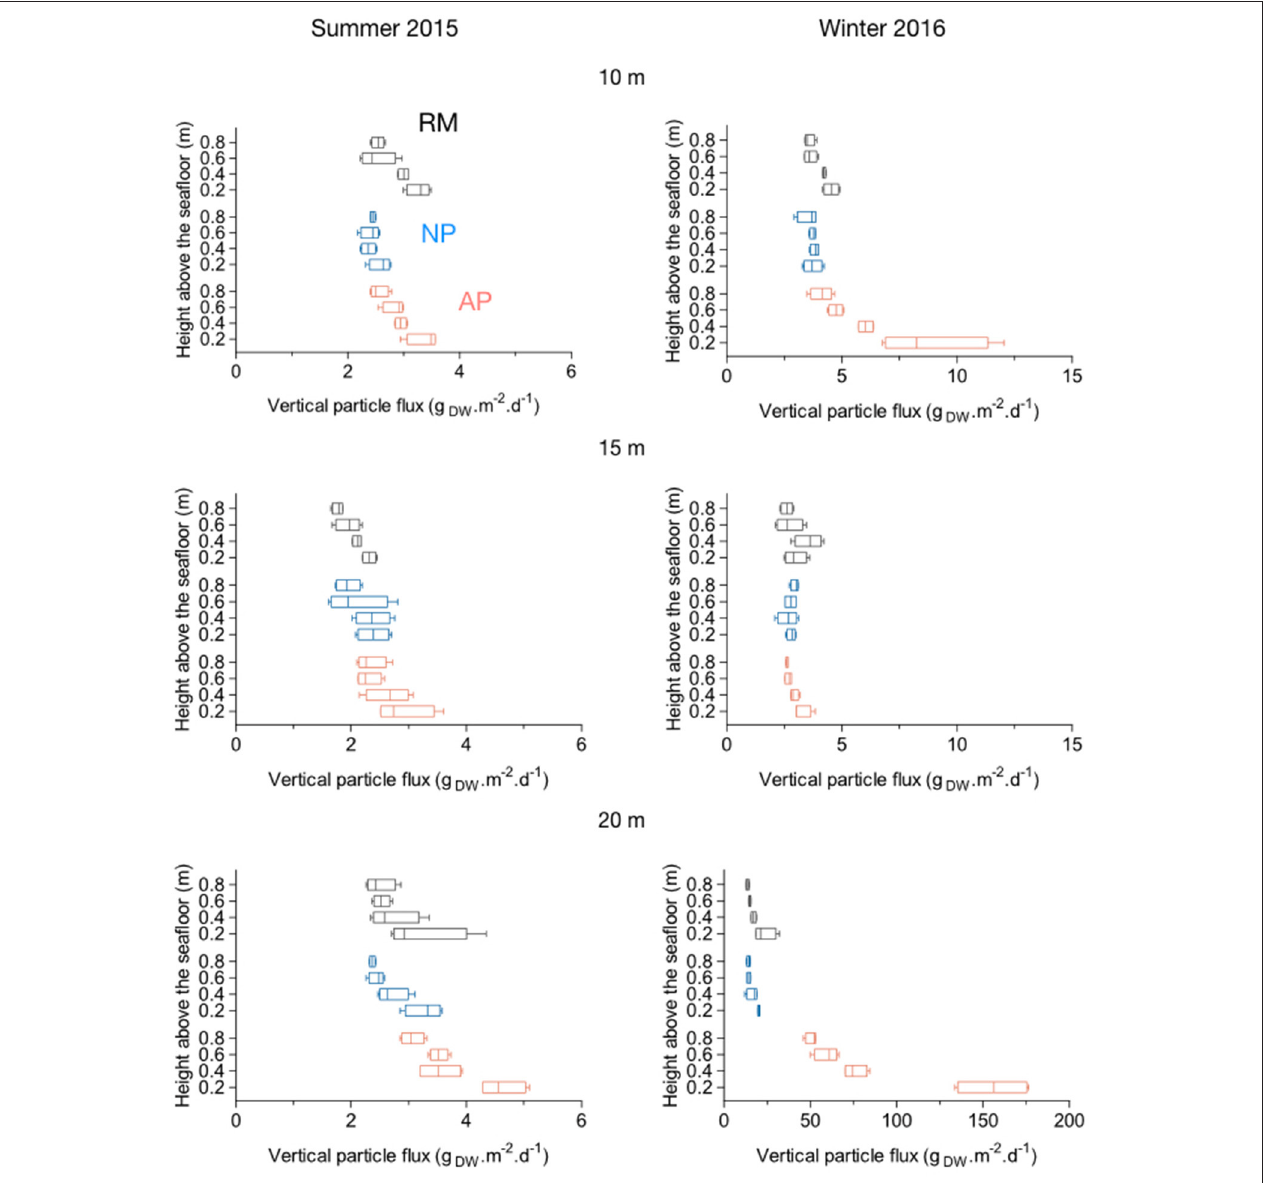
FIGURE 9 | Boxplots of vertical particle fluxes (resuspension) within natural (NP) and anchoring patches (AP) and in continuous reference meadows (RM) at 10, 15, and 20m depth in summer 2015 and winter 2016. Double bars represent minimum and maximum